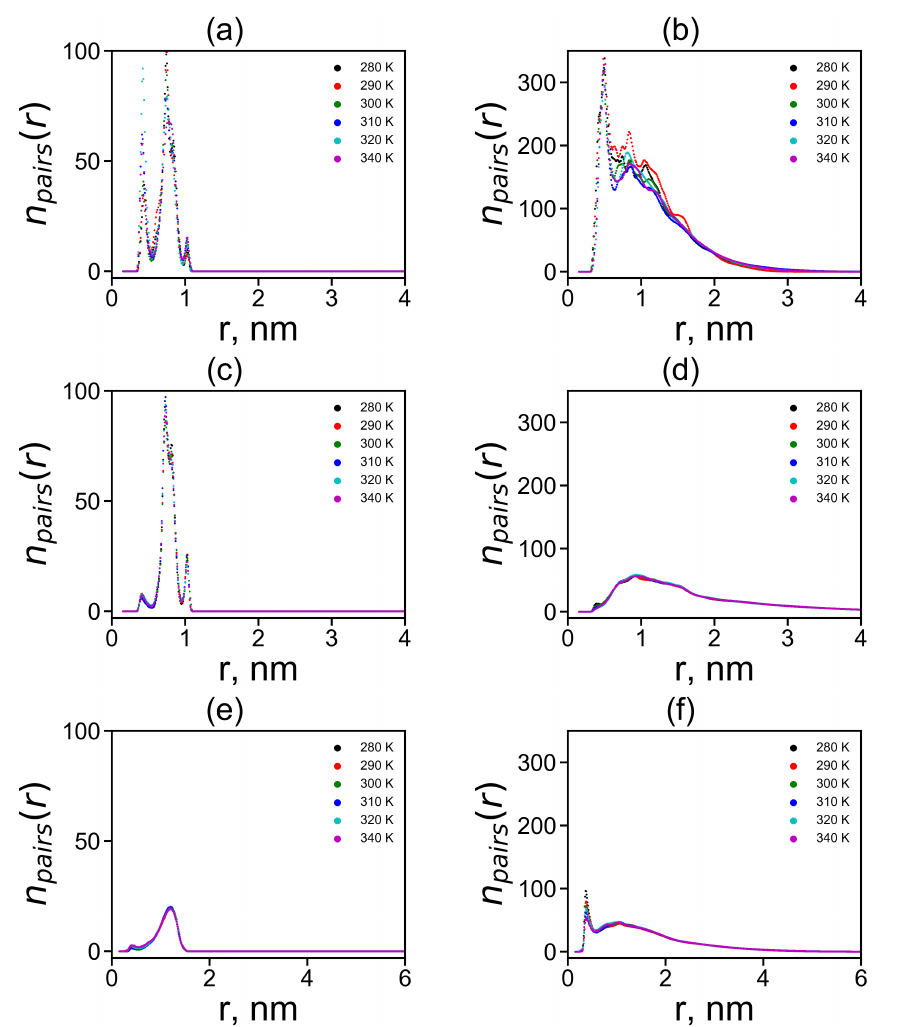
Figure 11. The radial distribution functions n pairs ( r ) of the centers of imidazole–imidazole (or guanidine–guanidine) groups at different temperatures ( a , c , d ) for pairs between neighboring groups and ( b , d , e ) for pairs between non-neighboring groups in Lys–2His ( a , b ), Lys–2Hisp ( c , d ) and Lys– 2Arg ( e , f